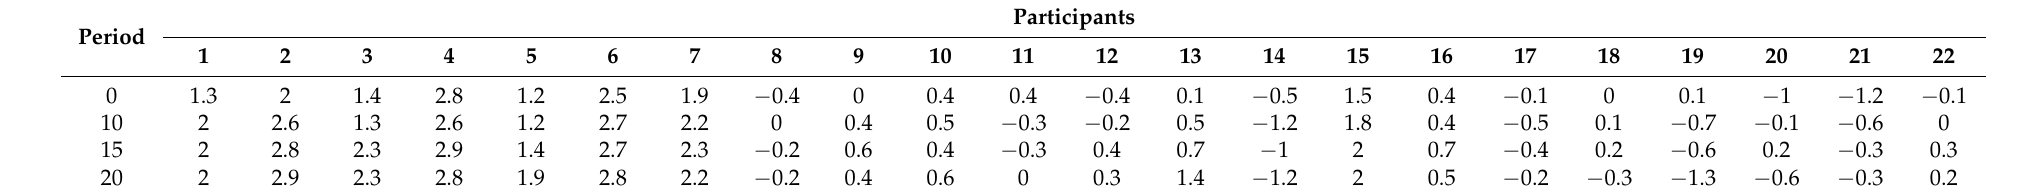
Table 5. Asymmetry analysis for sensory thermography.